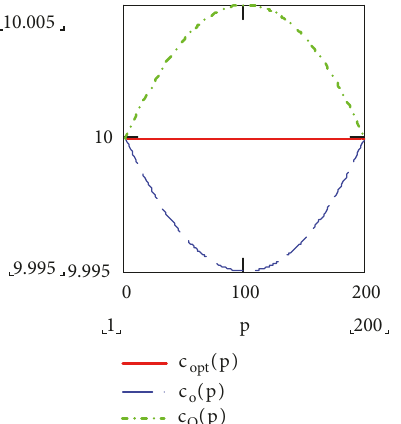
Figure 4: Free function variations for the traffic flow in comparison with the extremal solution (optimal function).